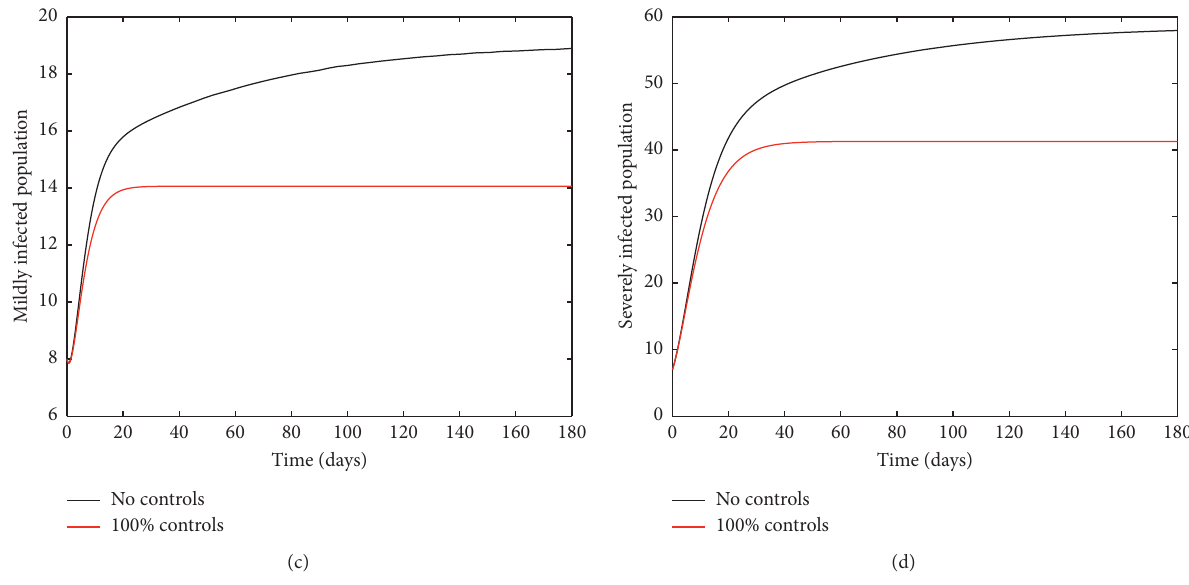
Figure 1: Time series of S , E , I